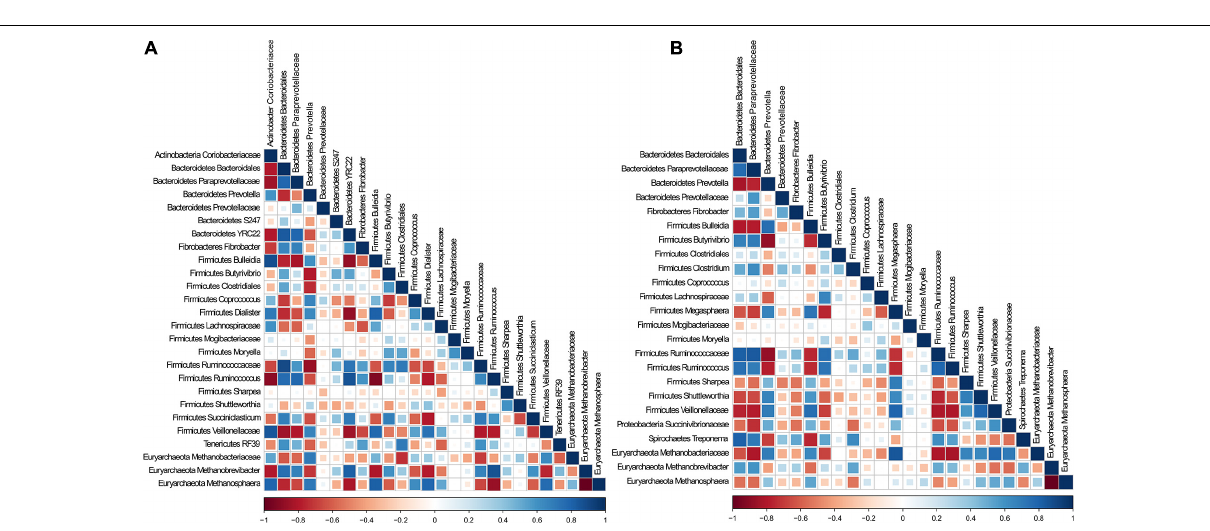
FIGURE 3 | Analysis of association patterns among microbial lineages scored using Spearman correlation for (A) DNA and (B) cDNA. Individual taxa were considered present in a sample if their sequence proportion was at least 0.01% of relative abundance. Correlations are shown by the color code (blue: positive correlations, red: negative